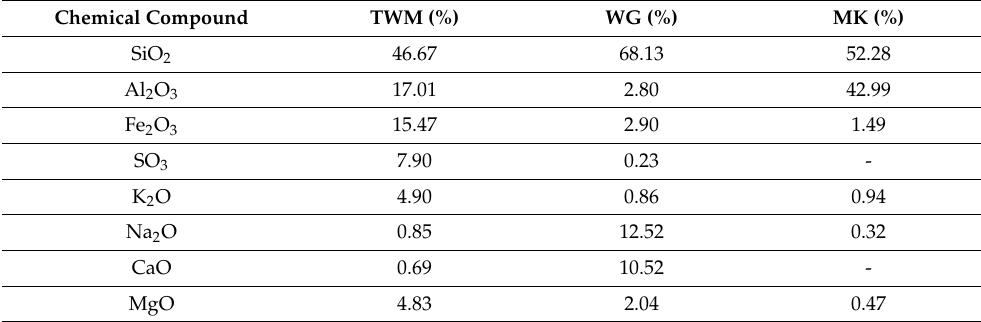
Table 1. Chemical composition of tungsten waste mud (TWM), waste glass (WG) and metakaolin (MK) obtained by scanning electron microscopy/energy-dispersive spectroscopy (SEM/EDS). Chemical Compound